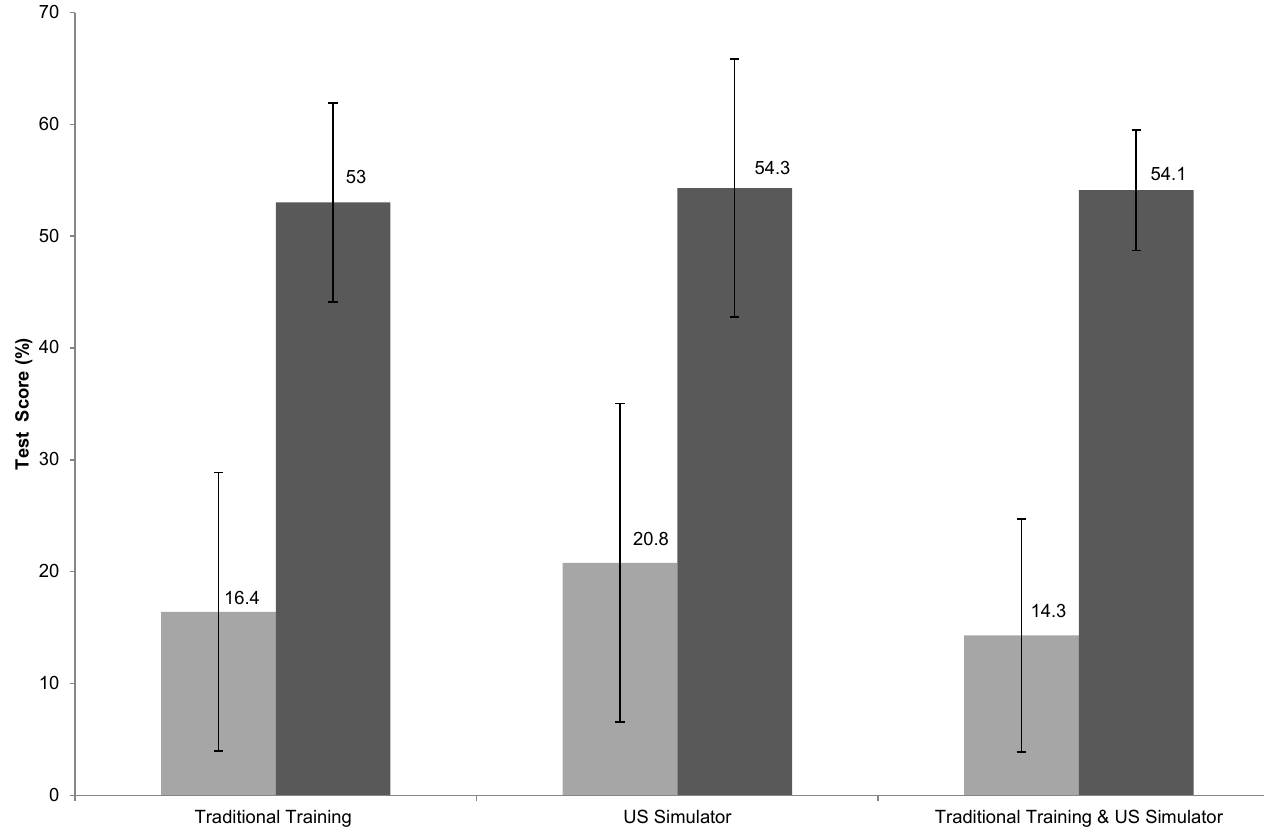
Figure 3. US and FAST knowledge pre- and post-evaluation scores. US , ultrasound; FAST , focused assessment of sonography in trauma Data are reported as mean with 95% CI. Lighter grey designates pre-course examination scores, darker grey designated post-course